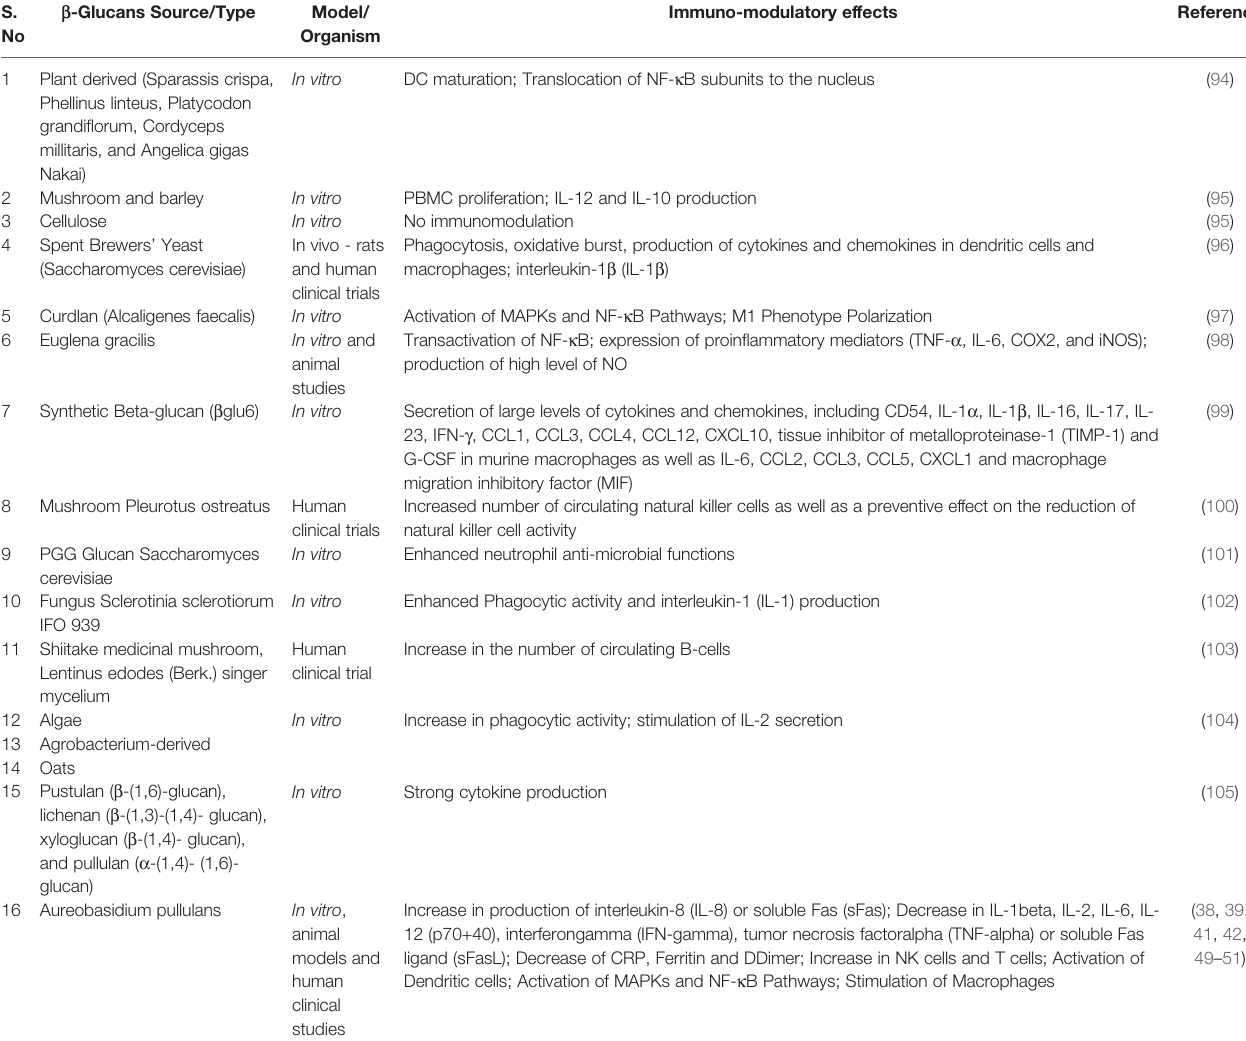
TABLE 2 | Immunomodulatory actions of different b